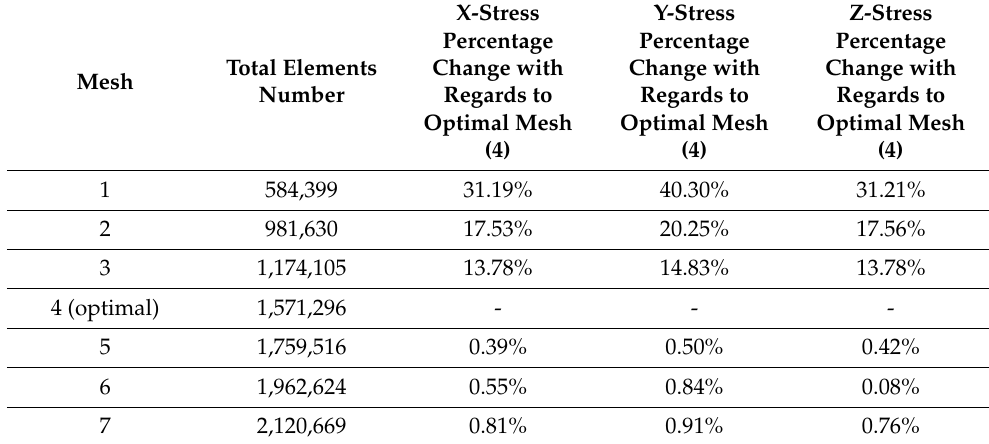
Table 6. Convergence